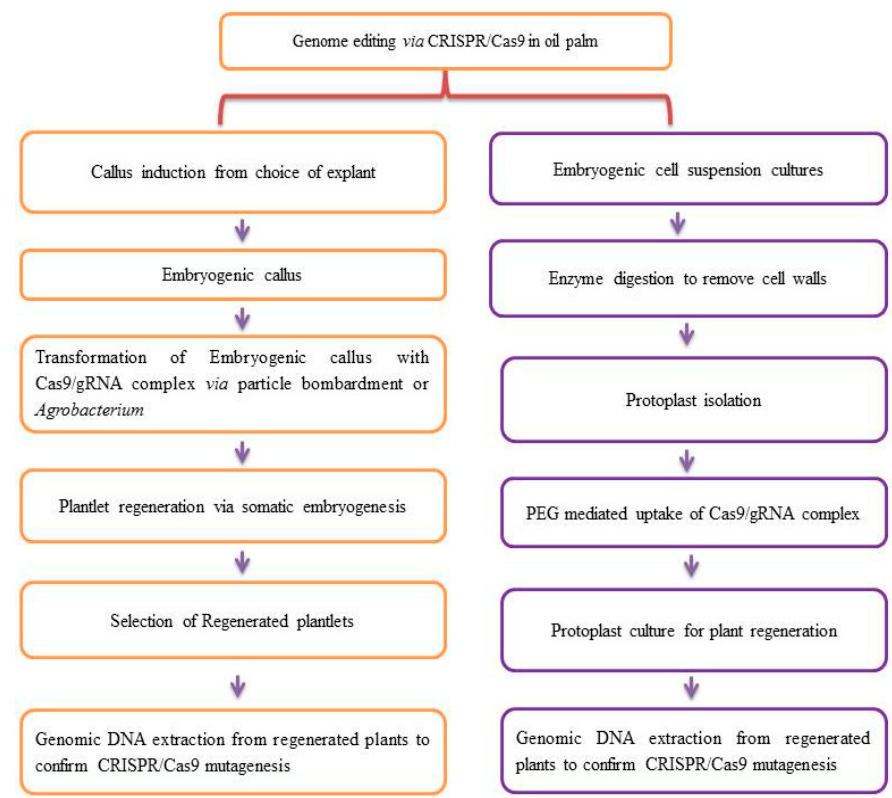
Figure 3. Proposed genome editing methods in oil palm via CRISPR/Cas9.